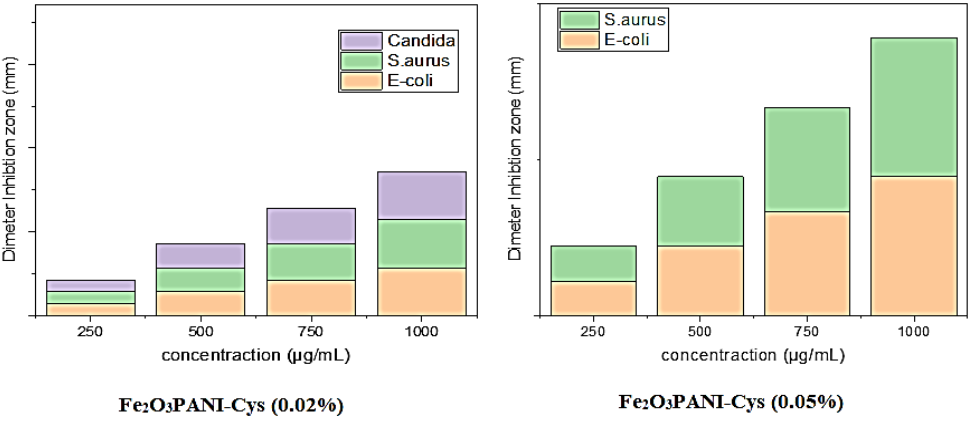
Figure 5(a): The statistics of the inhibition